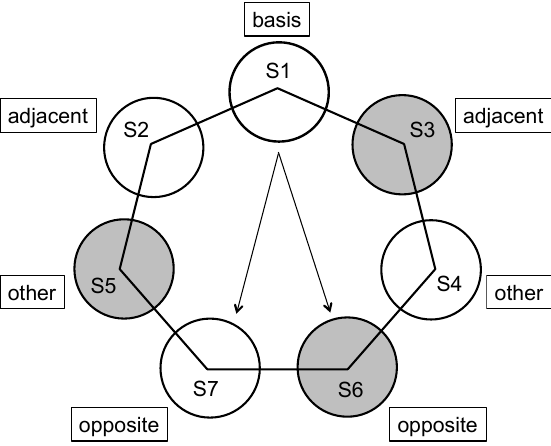
Fig. 2 Illustration of subunit arrangement comprised of “basis,” “adjacent,” “other” and “opposite”